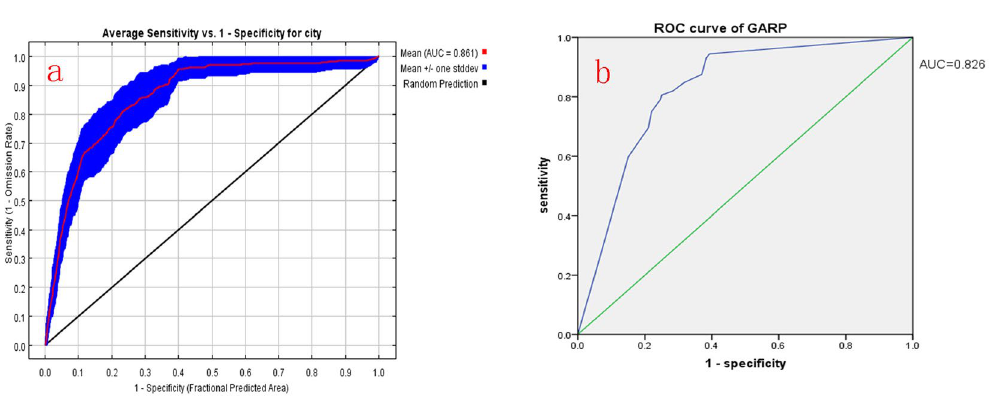
Figure 3. ROC curve of GARP model ( a ) and ROC curve of Maxent model ( b